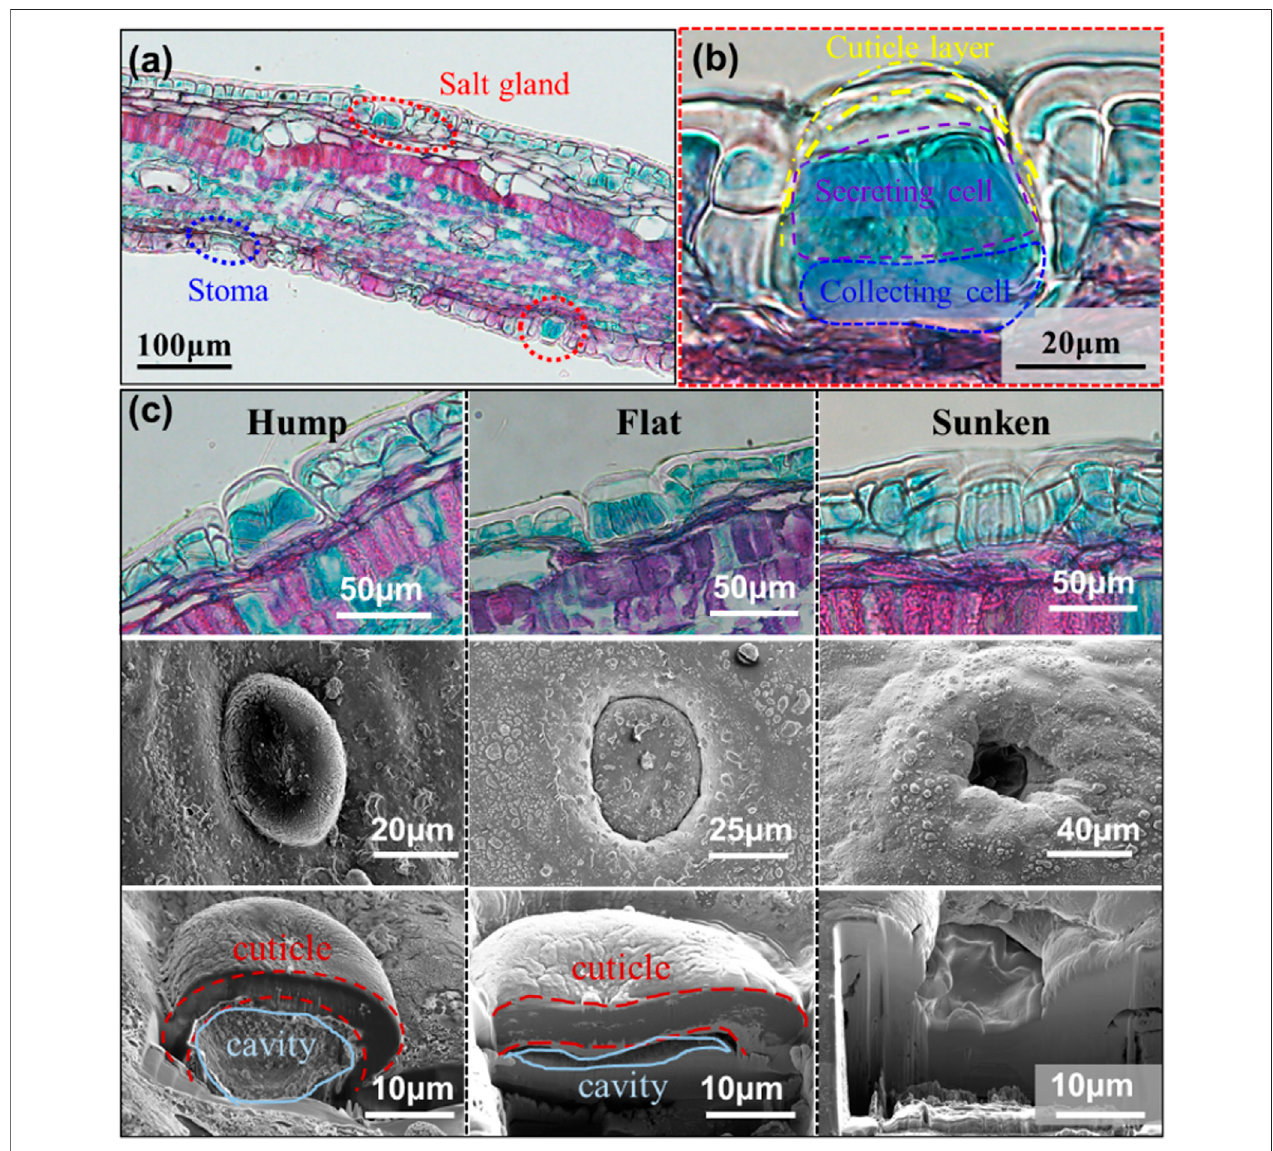
FIGURE 2 | The morphologies of the mangrove salt glands which are within the leaf surfaces. Optical images of (A) a sectional view of the stained leaf and (B) a magni fi ed view of the salt gland showing the cellular structure. (C) Optical and SEM images of the hump salt gland, the fl at salt gland, and the sunken salt gland.